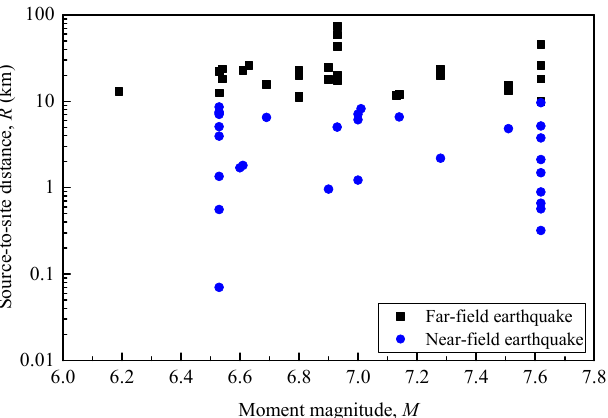
Figure 2. Information on the source-to-site distance and moment magnitude for both sets. Table 3. Selected ground motions.